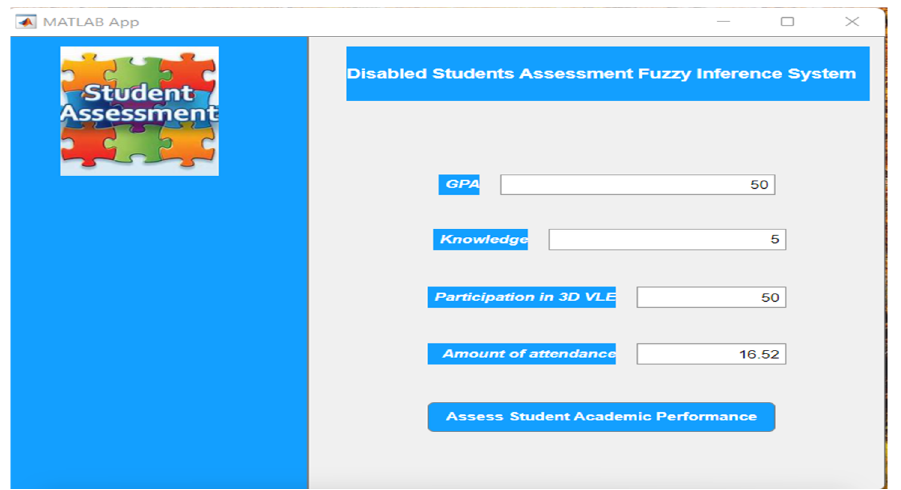
Figure 4. MATLAB Webapp user interface.